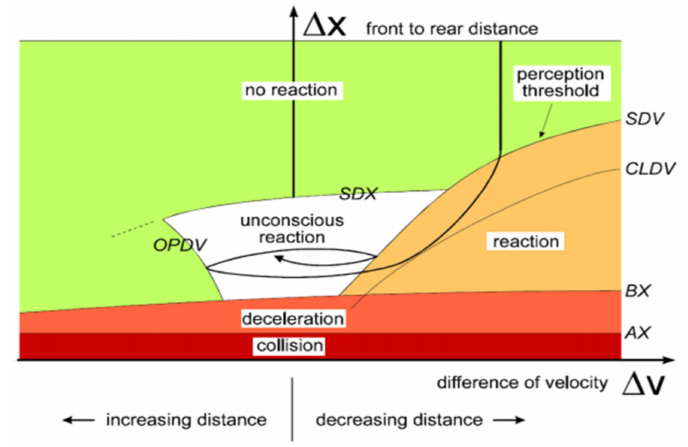
Figure 1. States of PTV Vissim model, source: PTV Vissim 9 manual [15].